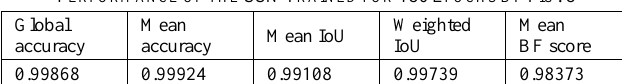
P ERFORMANCE OF THE SSN T RAINED FOR 150 E POCHS BY F IG .